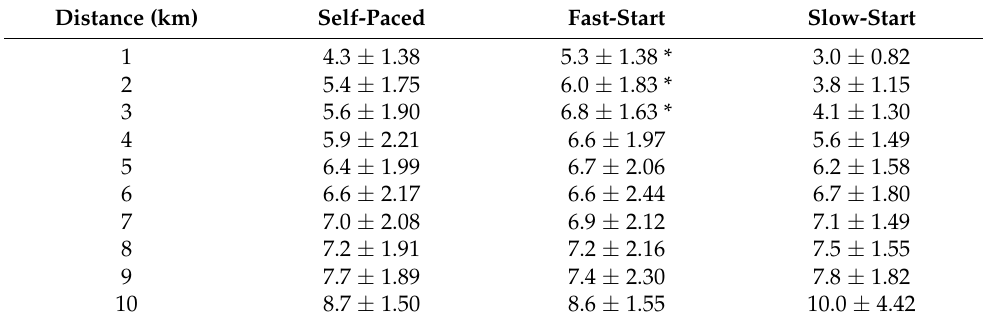
Table 4. Means ± standard deviations of rating of perceived exertion (RPE) during self-paced, fast-start, and slow-start time trials.